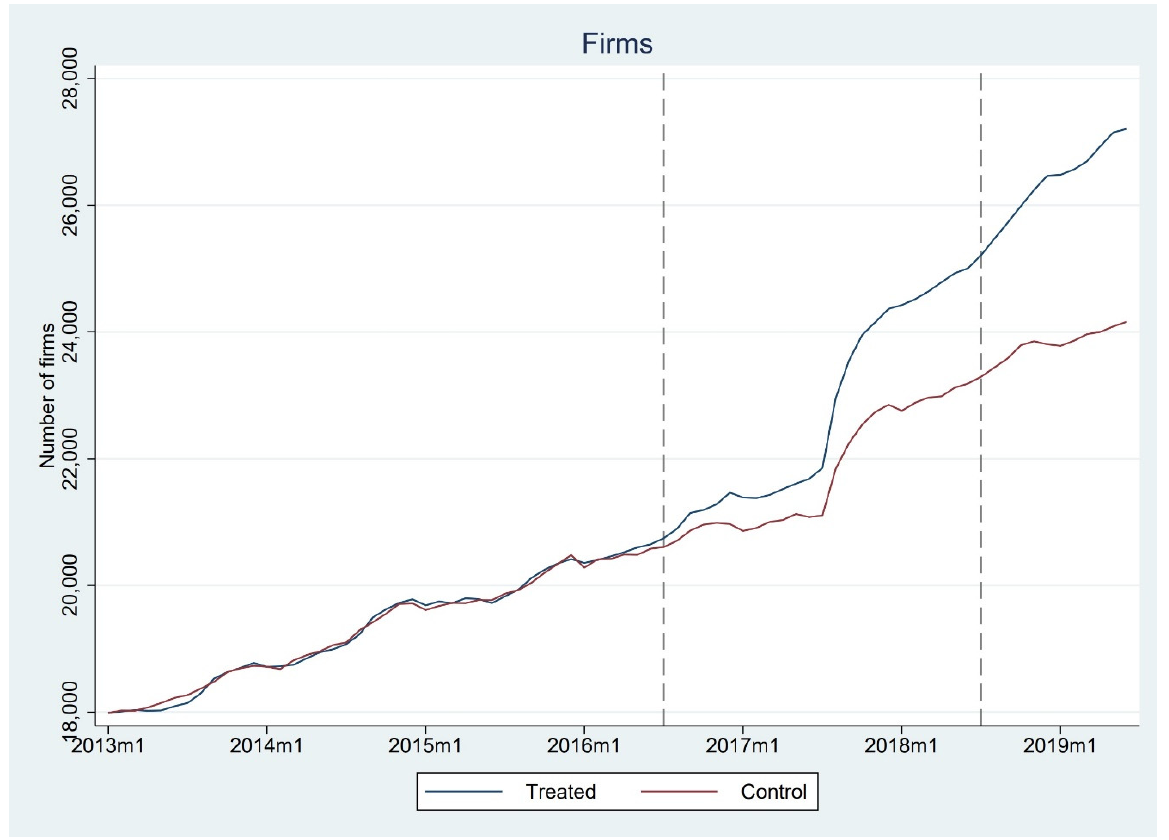
Figure A1. Evolution in the number of firms after two stages of FOP regulations.